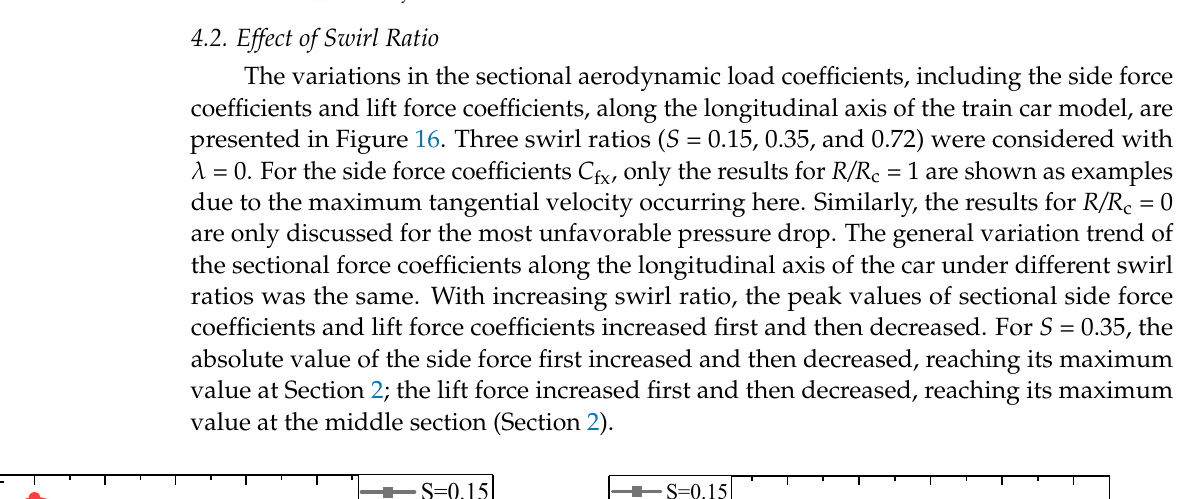
Figure 15. Contours of mean sectional aerodynamic load coefficient distribution ( S = 0.35, λ = 0). ( a ) C fx ; ( b ) C fz ; ( c ) C my .